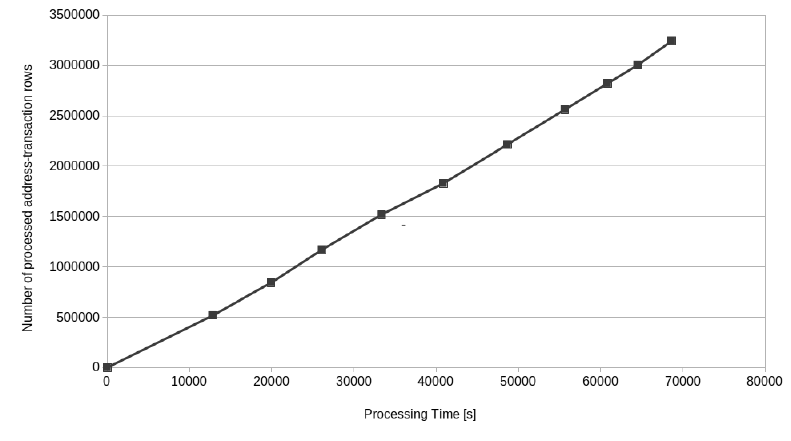
Figure 4. Number of examined address-transaction rows of the table inputSection versus the ETL processing time.